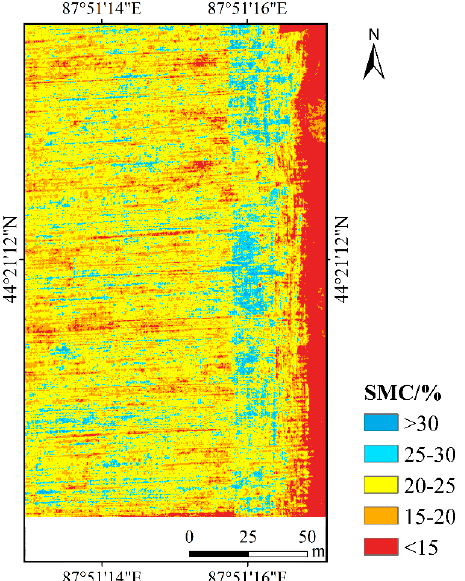
Figure 10. SMC digital soil mapping under the optimal estimation model strategy.